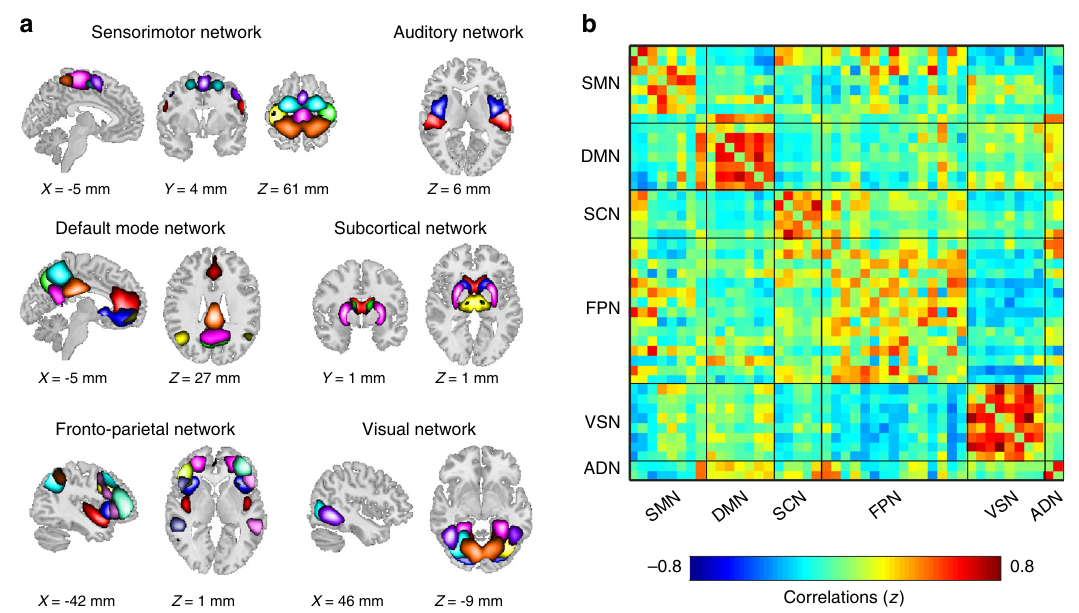
Fig. 1 Spatial maps of the identi fi ed intrinsic ICNs and static connectivity matrix. a 45 ICNs were identi fi ed and sorted into six resting-state networks. Each color represents a single ICN. b Group-averaged static functional connectivity matrix. ICNs intrinsic connectivity networks, SMN sensorimotor network, DMN default mode network, SCN subcortical network, FPN frontoparietal network, VSN visual network, ADN auditory